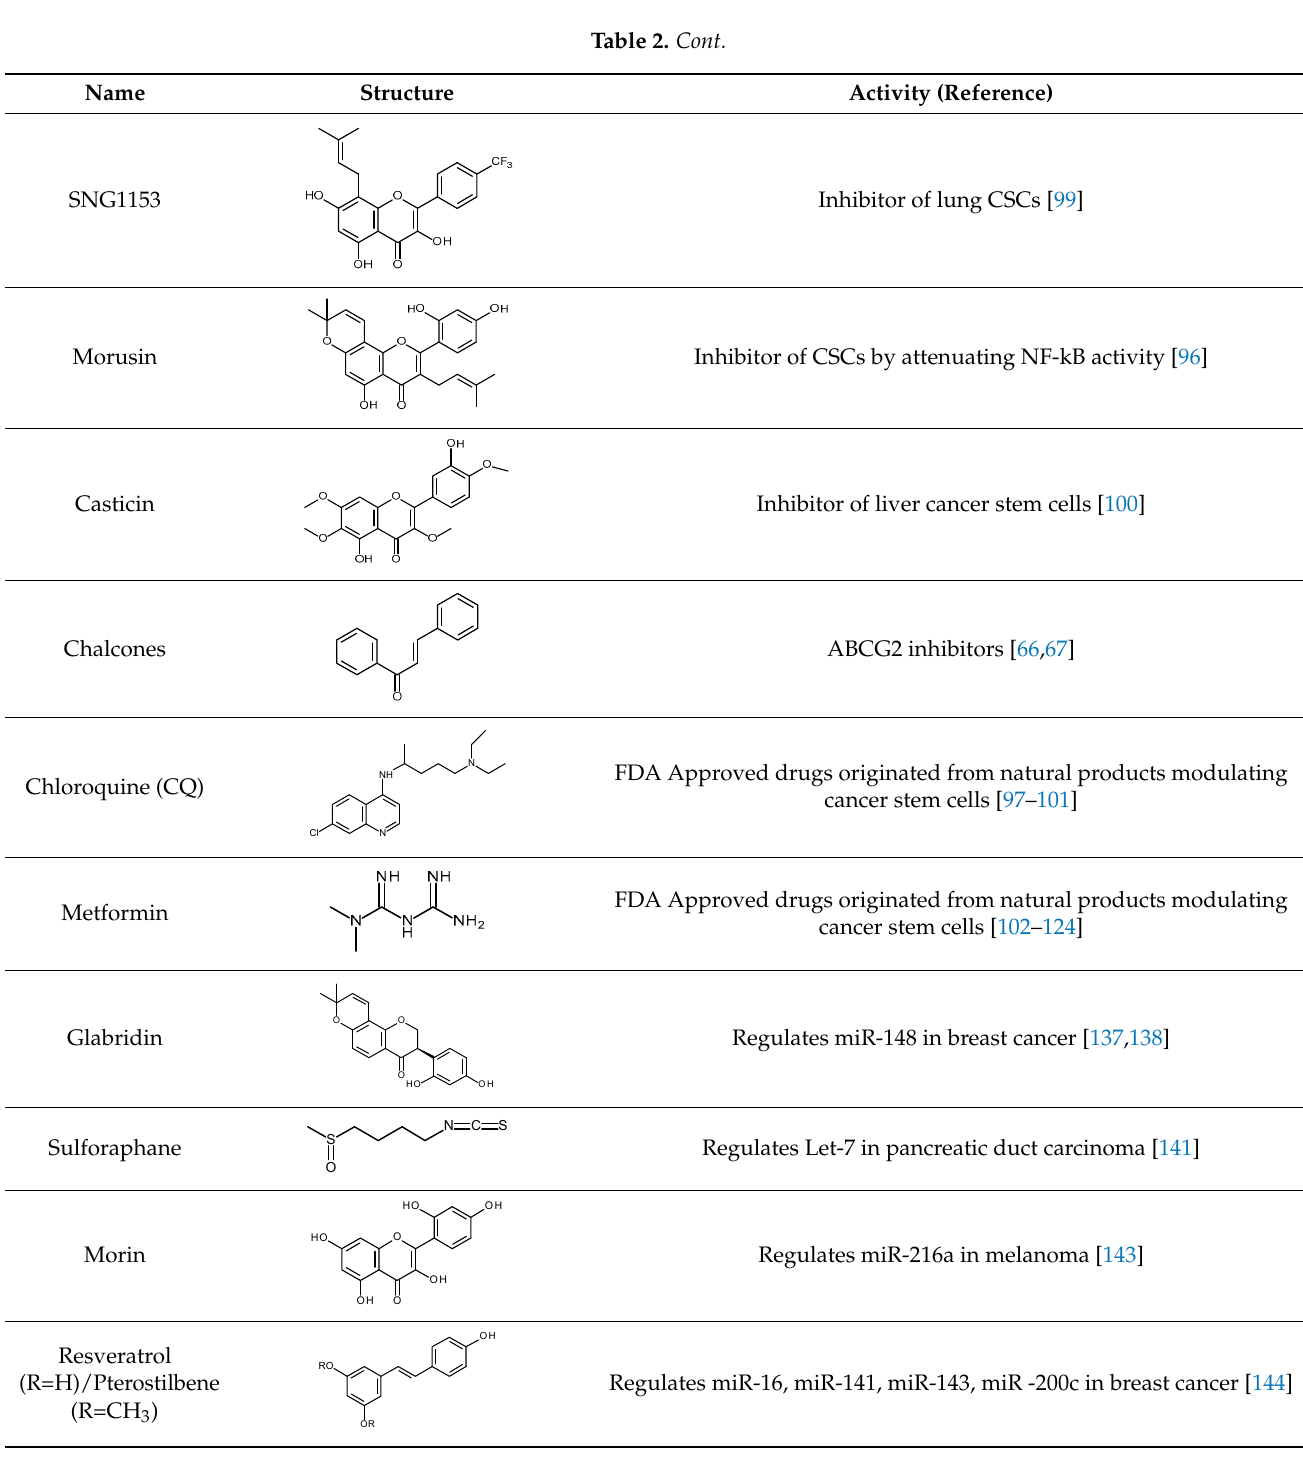
Figure 2. Graphical summary of flavonoids targeting major pathways in CSCs, including those regulated by microRNAs. Major pathways and CSC markers are in purple boxes; flavonoid names are in green; microRNAs are in red. Given the ubiquitous participation of miRNAs in the signaling pathways affecting CSCs, it is reasonable to assume that the effects of flavonoids on CSCs are mediated, inter alia, by miRNAs, and that these miRNAs are potential targets for supplementary thera- peutic intervention. 8. FDA-Approved Drugs Based on Natural Products Modulating CSCs The current manuscript focuses on anti-CSCs activity of flavonoids. However, no flavonoids with anti-CSC activity have been approved by the FDA. Thus, we will discuss plant-based FDA-approved drugs that exhibit anti-CSC activity. Among them, we chose to focus on Chloroquine (CQ) and metformin. Chloroquine (CQ): CQ was isolated from the bark of the Cinchona tree (cinchona Officinalis) and is an FDA-approved drug for the treatment and prevention of malaria. CQ is a member of the 4-aminoquinoline drug class. Currently, it is also being studied as a treatment against COVID-19 [145]. CQ functions as an autophagy inhibitor. Recent data indicated that chemotherapy resistance in epithelial ovarian cancer (EOC) is associated with autophagy activation. CSC isolated from EOC ascites exhibit higher basal autoph-